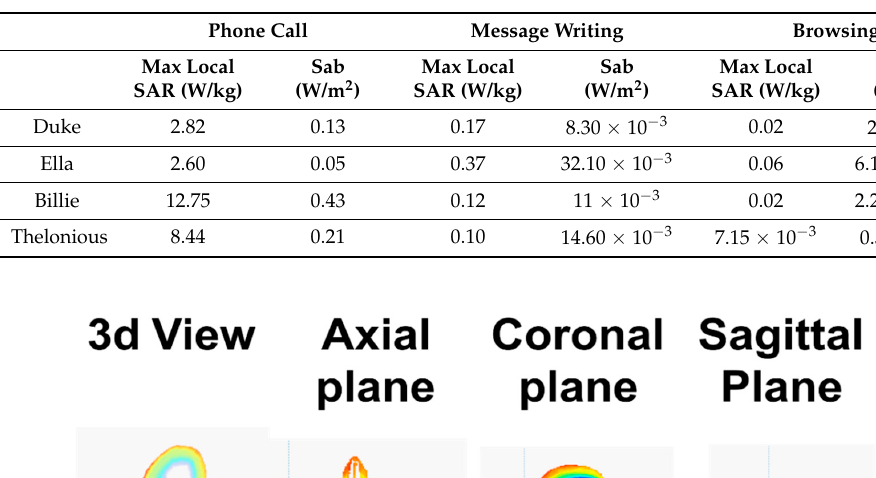
Table 2. Numerical results of finite-difference time-domain (FDTD) simulations.